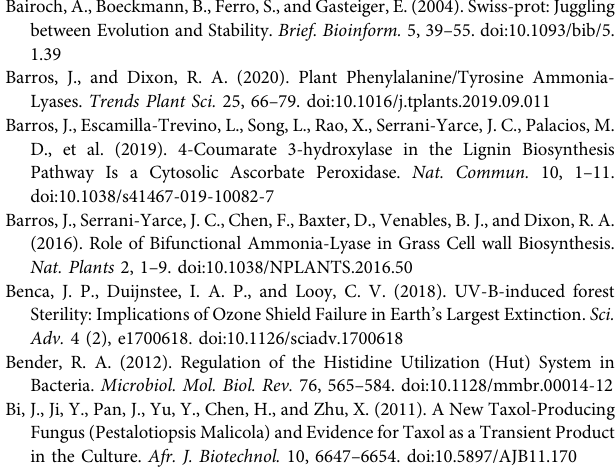
Supplementary Figure S1 | Bootstrap tree of arylalanine amino acid ammonia- lyase and aminomutase homologs retrieved from Swissprot. Supplementary Figure S2 | Partial sequence alignment of eukaryotic PTALs, prokaryotic TAL/TAMs, and certain PAL in monocots. Shown is the location of the residues in the active center that are suggested to represent major roles for substrate selectivity. The speci fi c residues in various domains are highlighted in different